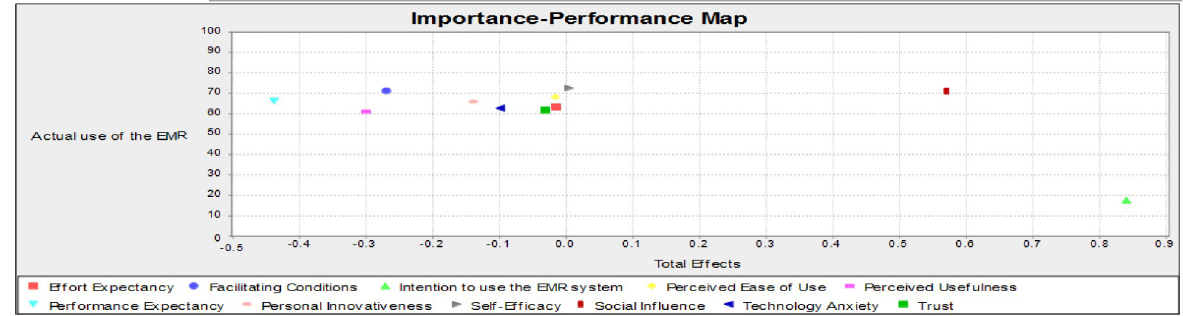
Fig 7. IPMA results.